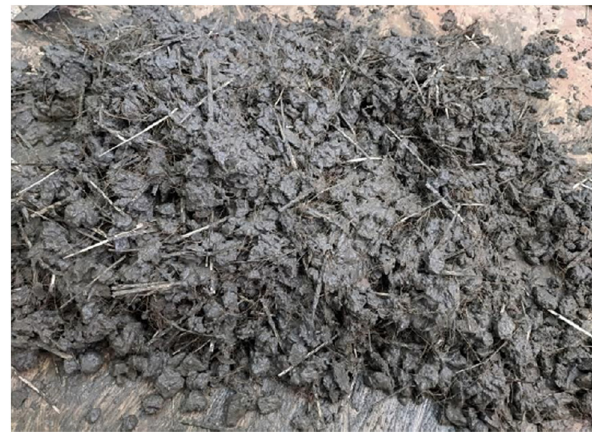
Figure 5: Mixing ( coir fi ber 0.5% of the total volume of concrete ) .